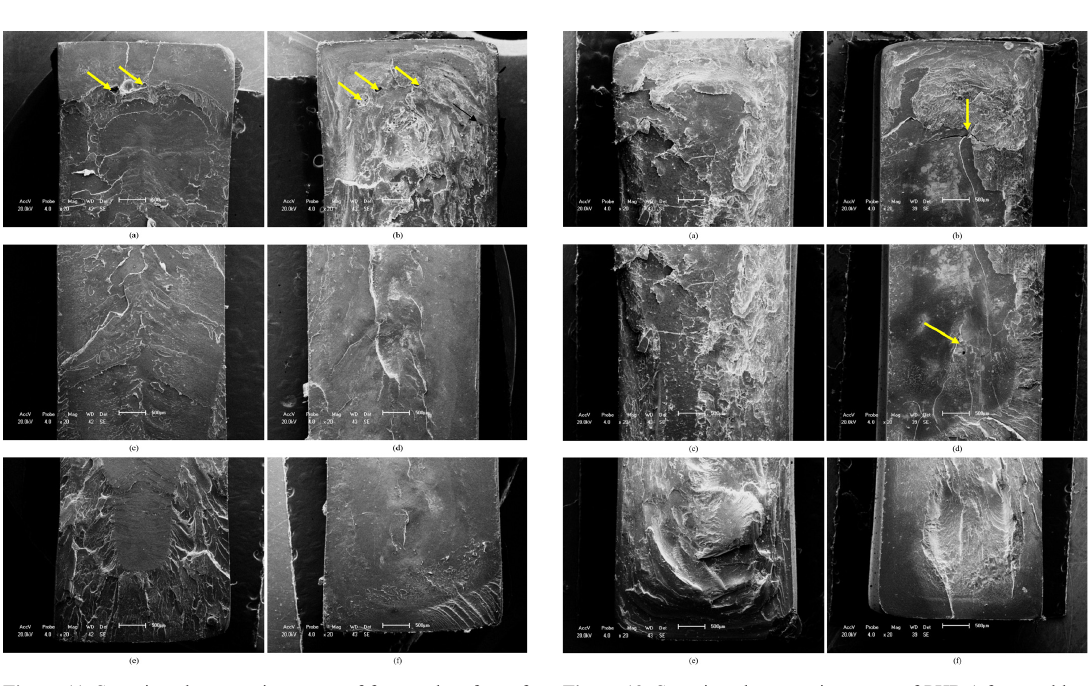
Figure 11. Scanning electron microscopy of fractured surface of PHB-1 bars, during stress versus strain tests at 0.1 mm/min. Images (a), (c), (e): upper border, middle and lower border, respectively, of unexposed bars. Images (b), (d), (f): upper border, middle and lower border, respectively, of bars exposed to NaOH.